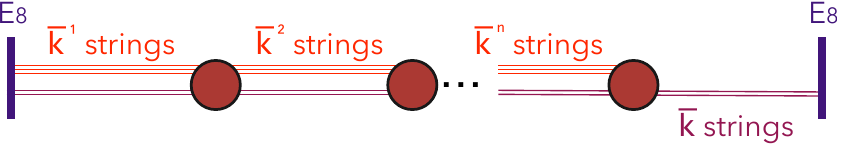
Figure 2 . Fractional and full strings in N = (1 ; 0) E 8 (cid:2) E 8 heterotic